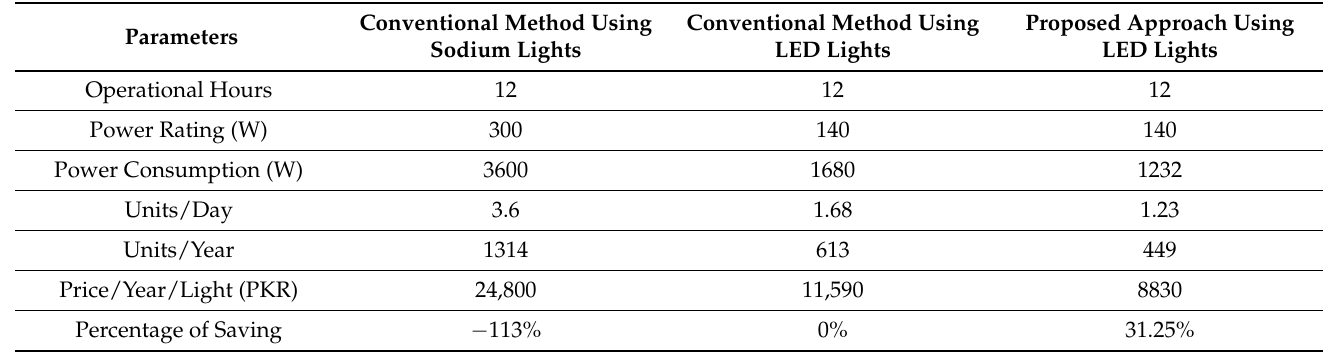
Table 3. Electrical power consumption using the conventional method and proposed